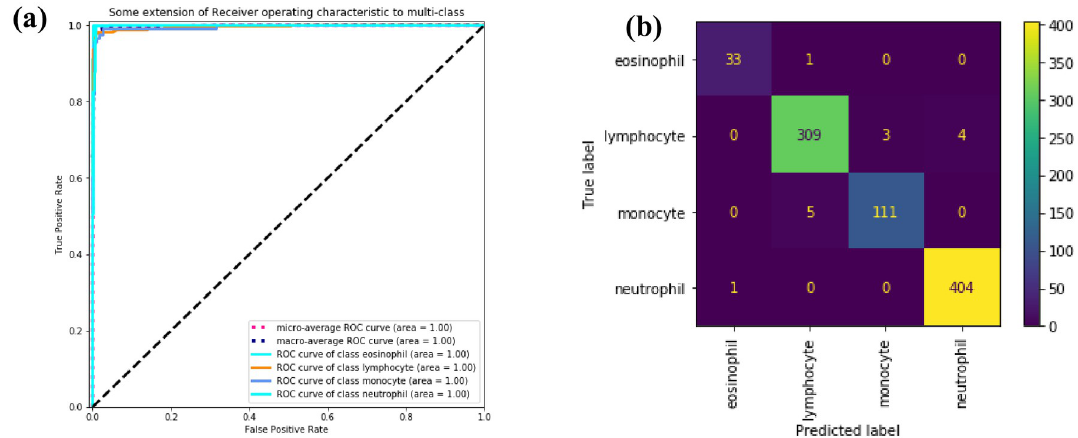
Fig 11. ROC curve and confusion matrix. (a) ROC curve of four subtypes of WBC. (b) Confusion matrix of four subtypes of WBC.